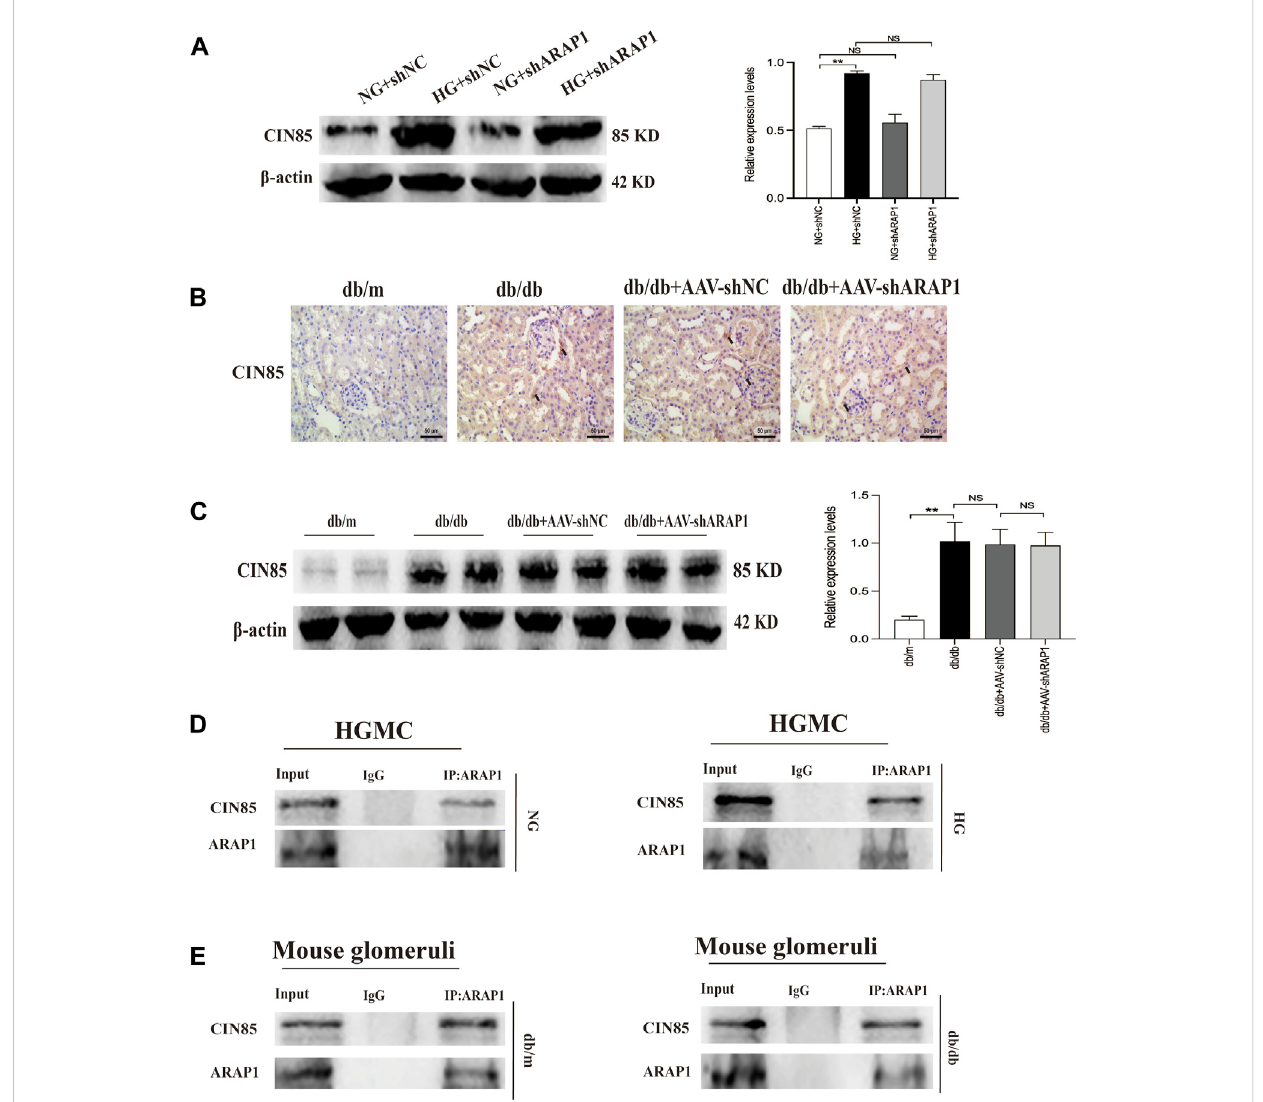
FIGURE 5 Interaction between ARAP1 and CIN85 (A) Forty-eight hours after transfection of ARAP1 shRNA in the NG group and HG group, the protein expression of CIN85 was examined by Western blot analysis. (B) IHC detection of CIN85 in kidney tissues from db/m, db/db, db/db + AAV-shNC and db/ db + AAV-shARAP1 mice (×400). Bar = 50 μ m. Arrows indicate positive staining. (C) The effect of AAV2/9-shARAP1 on the proteinexpression of CIN85 in the isolated glomeruli lysates of mouse kidney tissues was examined by Western blot analysis. (D,E) The physical interaction between ARAP1 and CIN85 in human glomerular mesangial cells and mouse glomeruli was detected by Co-IP analysis. IgG was used as a negative control. In all panels, the data are representative of at least three independent experiments. Data are presented as the mean ± SD. * p < 0.05, ** p < 0.01, NS, not signi fi